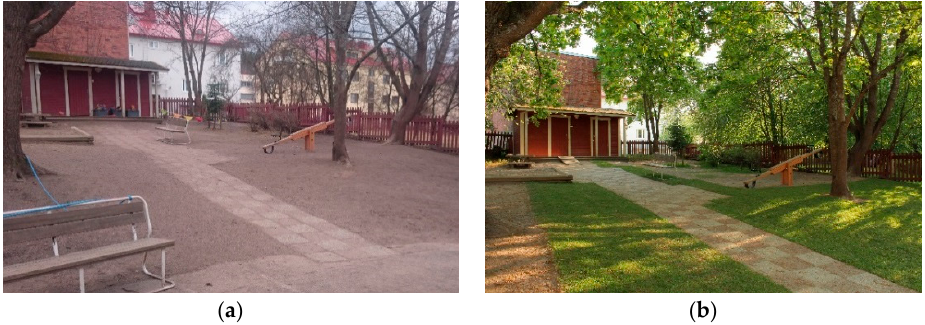
Figure 1. ( a ) Before the intervention, the daycare yards were mostly covered by mineral soil materials; ( b ) After the intervention, the daycare yards were covered by forest floor mat and sod. Photos: Aki Sinkkonen ( a ) and Mira Grönroos ( b ).